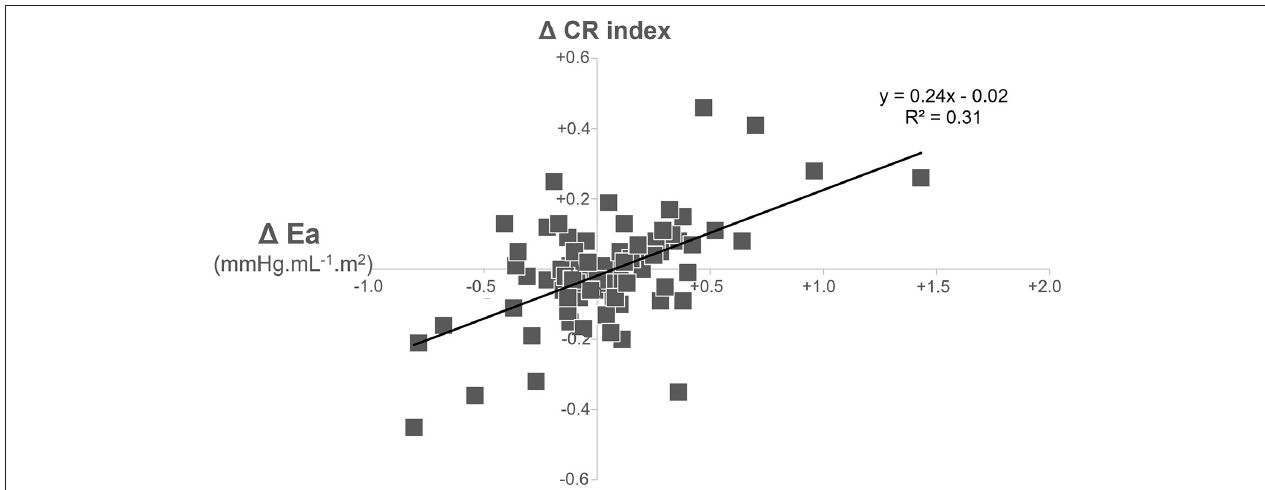
FIGURE 1 | Correlation between baseline to follow-up changes in effective arterial elastance (Ea) and in the left ventricular concentric remodeling (CR) index in the overall population of obese subjects.